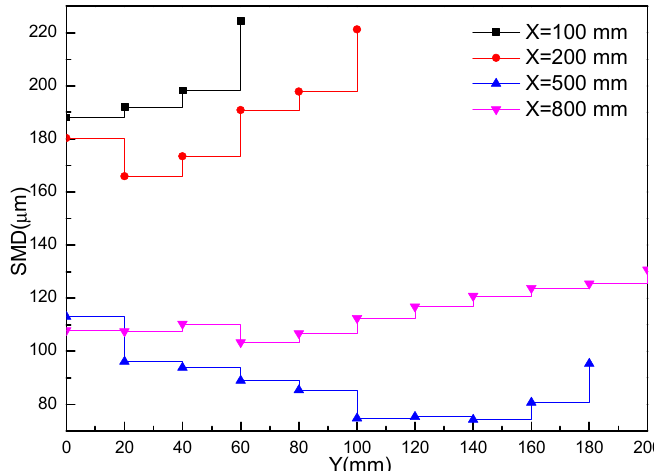
Figure 7. Comparison curve of the axial velocity along the axial direction.